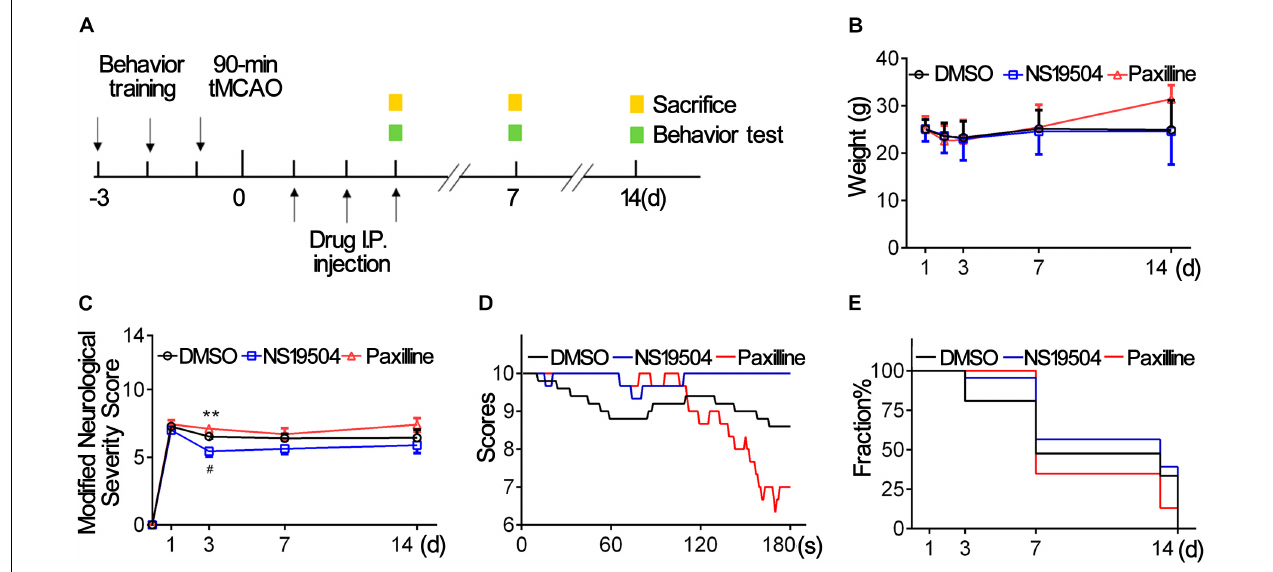
FIGURE 5 | Activation of BK channels ameliorated stroke outcomes. (A) Experiment design of the animal experiment. Three days before tMCAO, mice were subjected behavior training. After a 90-min tMCAO surgery, mice were divided randomly into four groups (sham, DMSO, NS19504, and Paxilline). At 1, 3, 7, and 14 days, behavior tests were performed, and protein and RNA samples were collected. (B) Weight changes of mice in three groups at 1, 2, 3, 7, and 14 days after tMCAO. (C ) Modified Neurological Severity Score of three groups at 1, 3, 7, and 14 days after tMCAO. (D) Average score per second of three groups of hinging wire at 3 days after tMCAO. (E) Survivorship curve during 14 days of three groups after tMCAO. Data are mean + SE, n = 21–23 per group at 1 day, n = 17–23 per group at 3 days, n = 8–13 per group at 7 days, n = 3–9 per group at 14 days. *NS19504 vs. Paxilline group, ** p < 0.01. # NS19504 vs. DMSO, # p <